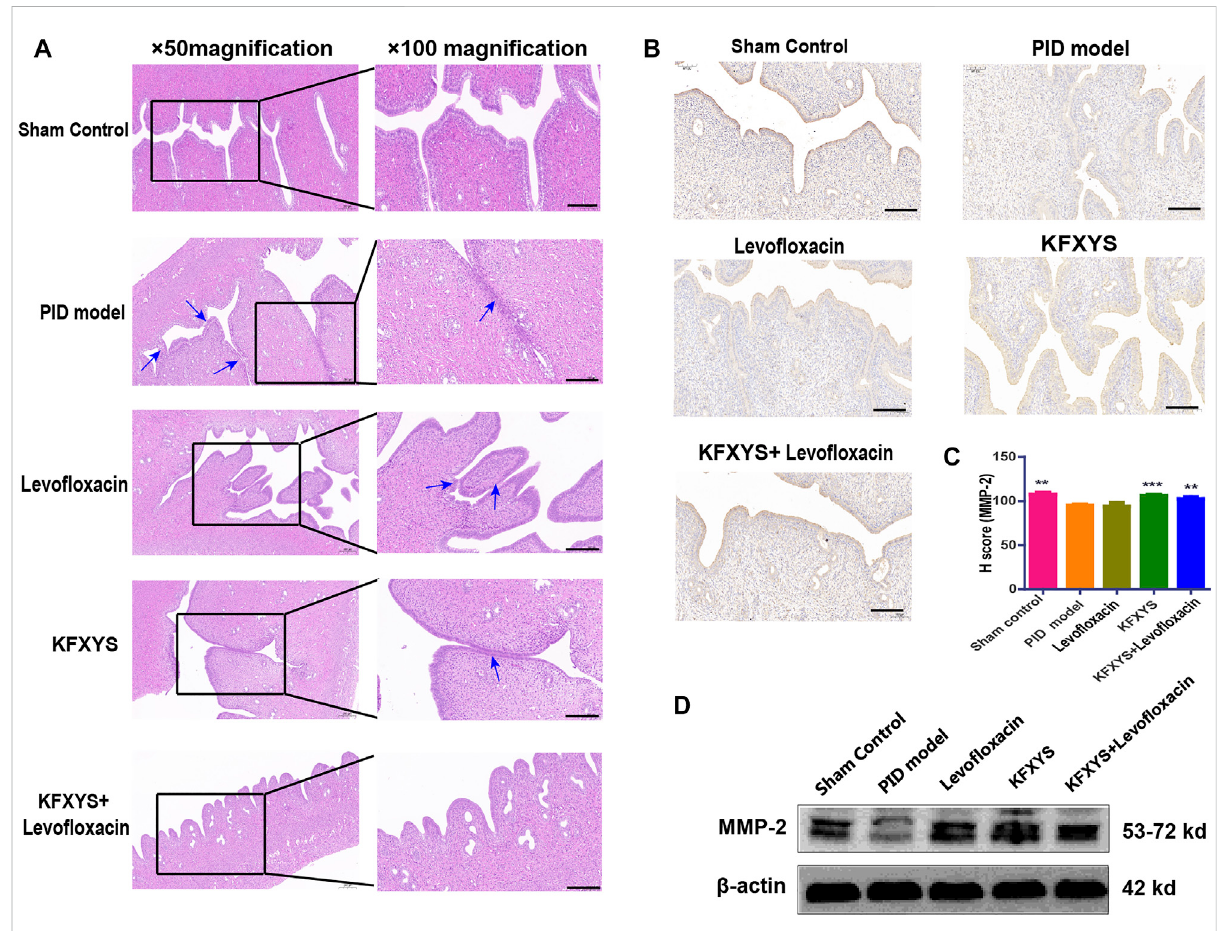
FIGURE 6 Histopathological images showing the degree of adhesion of uterine tissue at D49 and analysis of MMP-2 expression by immunohistochemistry.(A) UterinemucosaadhesionwasobservedbyHEstaining.Theblackarrowsindicatebandsofadhesivetissue.Imageswere takenat50×or100×magni fi cation. (B) ImmunohistochemistrywasusedtoanalyzetheproteinexpressionofMMP-2inadhesiveuterinetissuefrom the different groups. (C) Semiquantitative analysis by the H-score of MMP-2. (D) Western blot analysis was used to measure the expression levels of MMP-2 at D49. β -actin was used as an internal control. Scale bar: 200 μ m. ** p < 0.01 vs the PID model group, and *** p < 0.001 vs the PID model